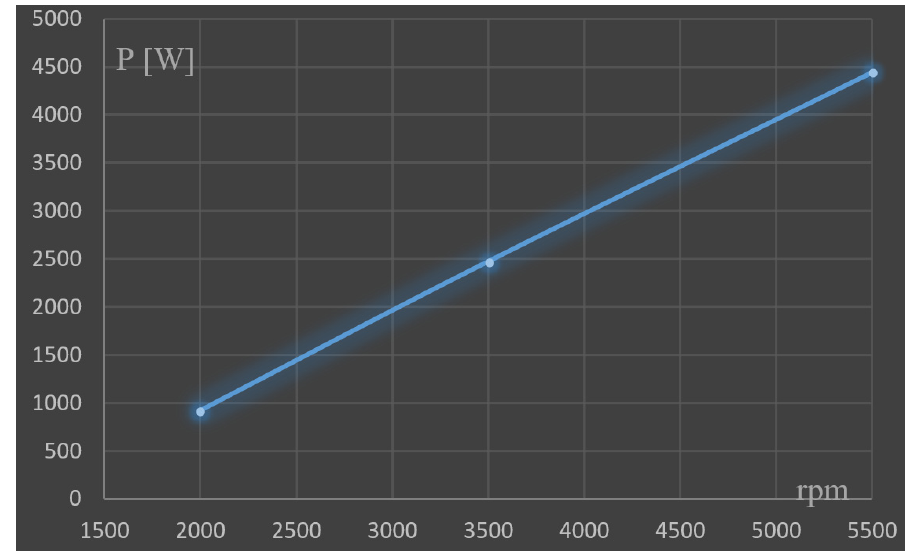
Figure 4. Required power trend depending on the ICE engine rotational speed.